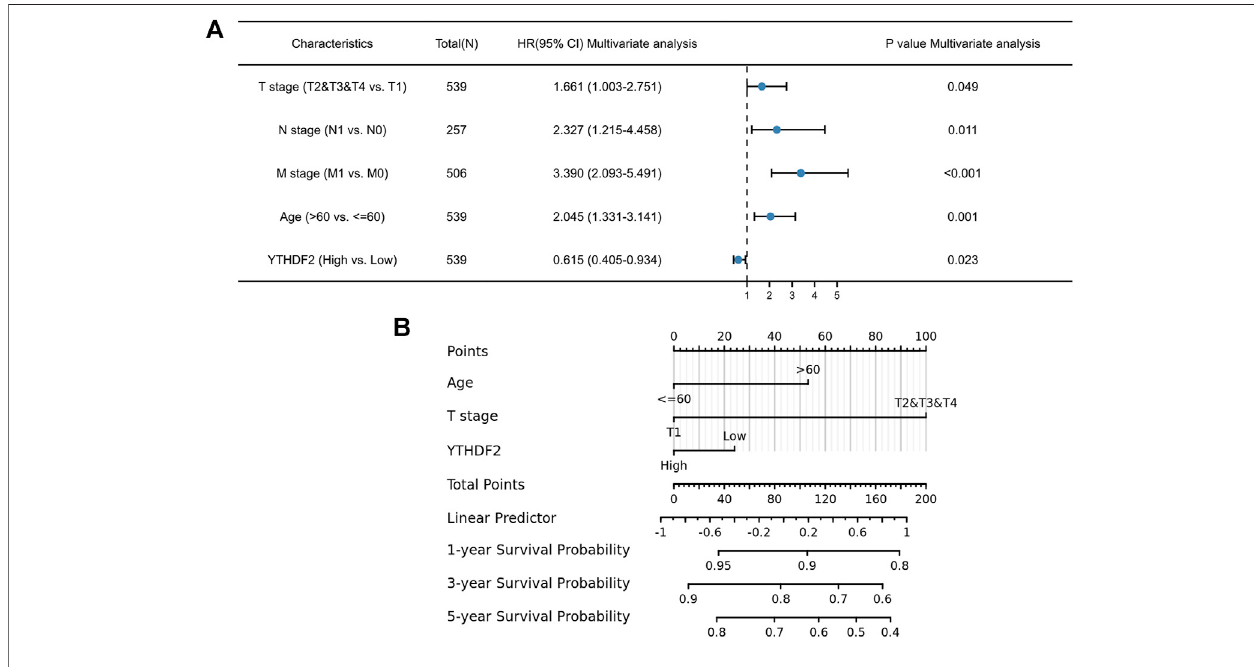
FIGURE 4 | Forest plot and nomogram construction. (A) Forest plot of the association between risk factors and overall survival (OS) in TCGA-KIRC patients. (B) Prediction model of nomogram construction. KIRC, Kidney renal clear cell carcinoma.